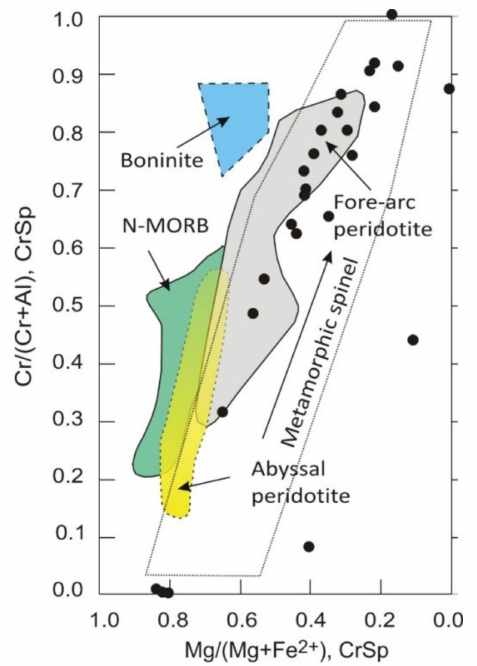
Figure 10. Data for spinel from the Tog and Shida peridotites. Abyssal peridotites, boninite, N-MORB are from [46,47]. Data for spinel in fore-arc peridotites are from [48,49]. The field of metamorphic spinel is after